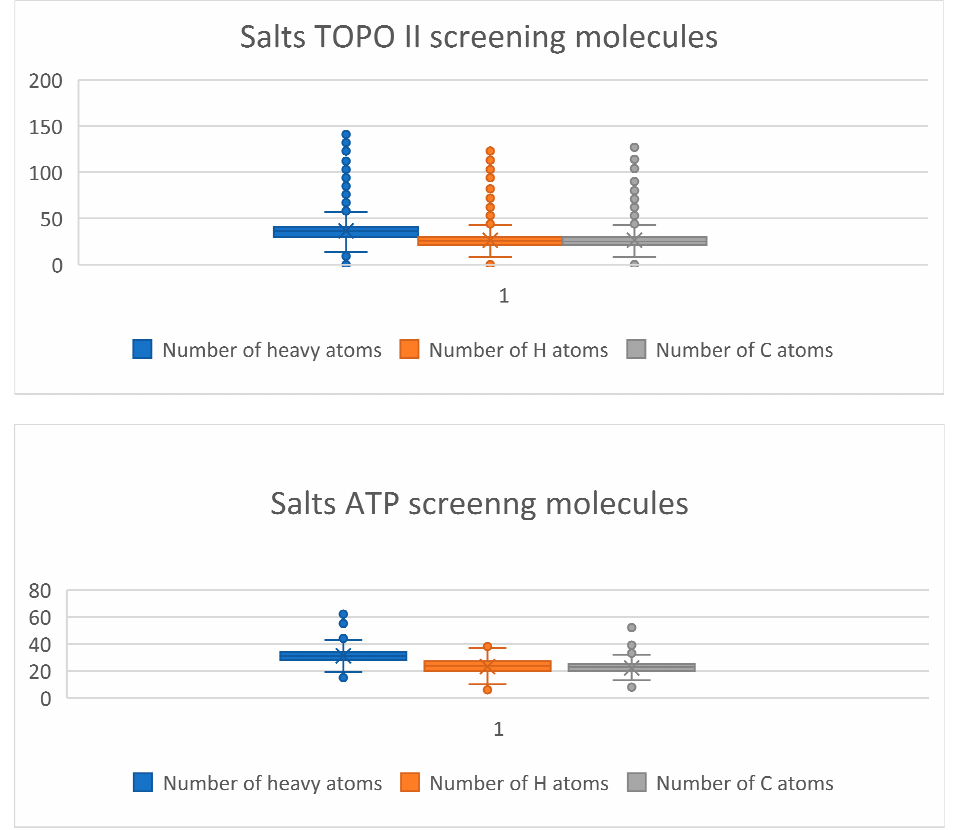
Figure 7. The structural composition of the molecular data set results after screening against bacterial ATP